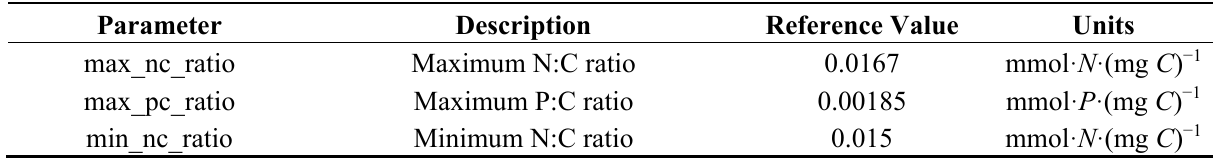
Table 3. List of parameters for consumers